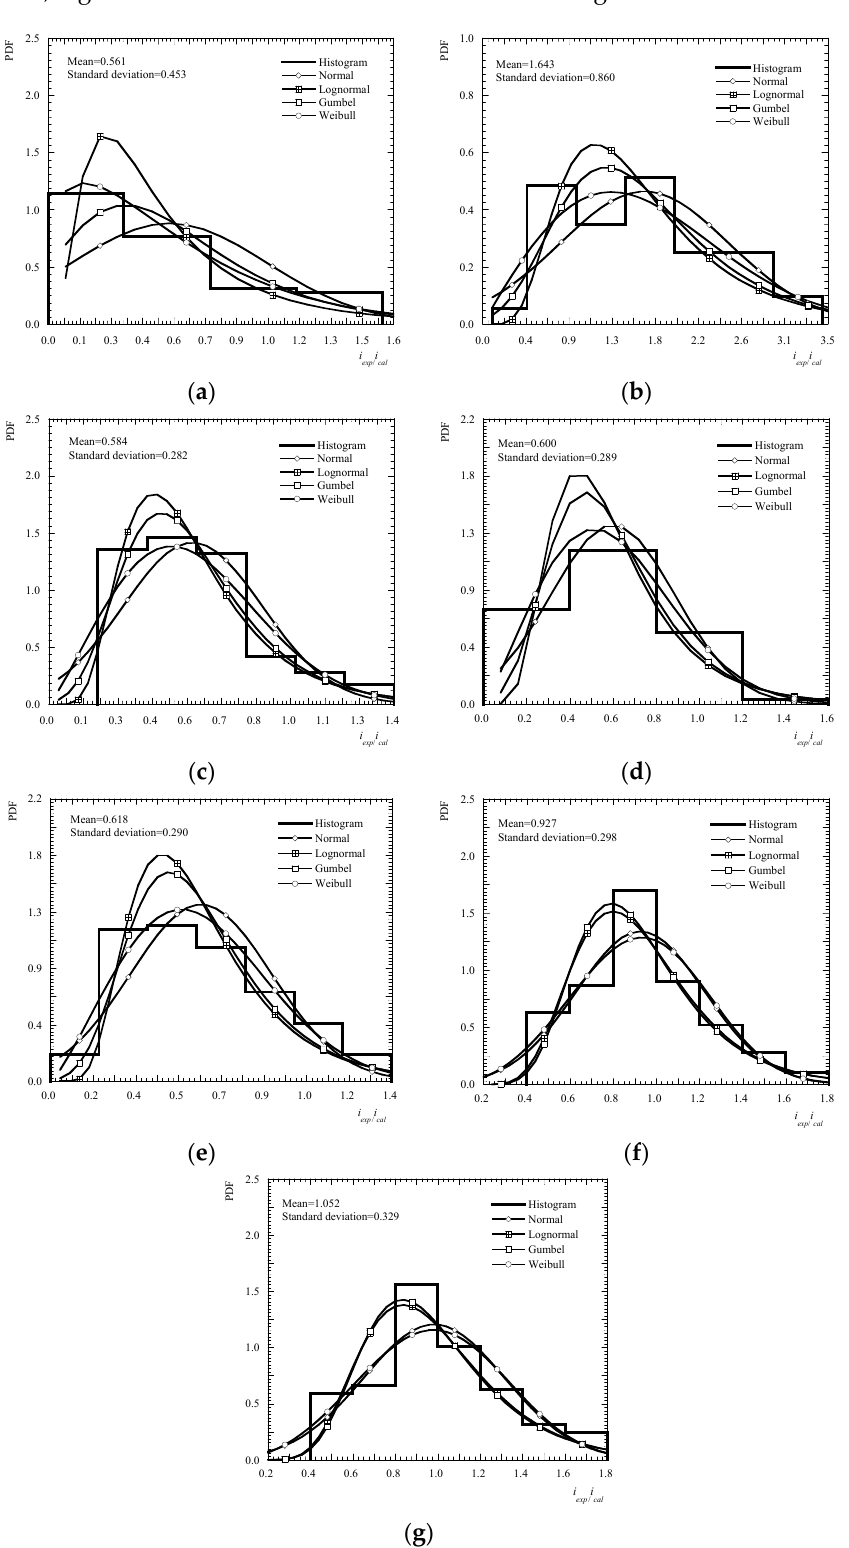
Figure 6. Histograms and statistical moments of model fitting results and error variables. ( a ) Liu and Weyers [15]. ( b ) Vu and Stewart [16]. ( c ) Kong et al. [22]. ( d ) Yu et al. [23]. ( e ) Guo et al [24]. ( f ) Lu et al. [25]. ( g ) New